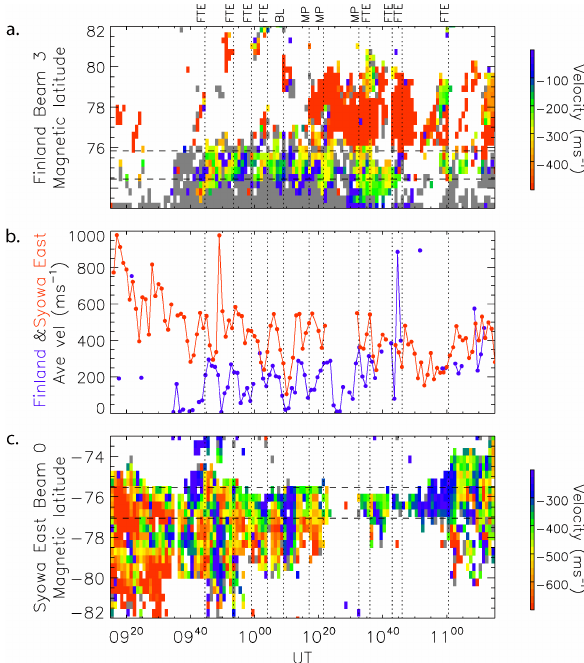
Fig. 3. (a) Line-of-sight velocity data from beam 3 of the Super- DARN Finland radar, colour-coded as indicated in the colour bar. (c) Velocity data from beam 0 of the Syowa East radar, presented in the format of (a), albeit with a different colour scale and a reversed latitude axis. (b) The mean velocity averaged over the latitude range indicated by dashed horizontal lines in (a) and (c) (and given pos- itive values in this case, though in each case the flow is directed away from the radars). The indigo trace corresponds to the Finland average velocities, whilst the red trace corresponds to the Syowa East average velocities. Superimposed on each panel are the times of FTEs, boundary layer (BL), and magnetopause (MP) encounters identified in the Cluster observations. (From Wild et al.,